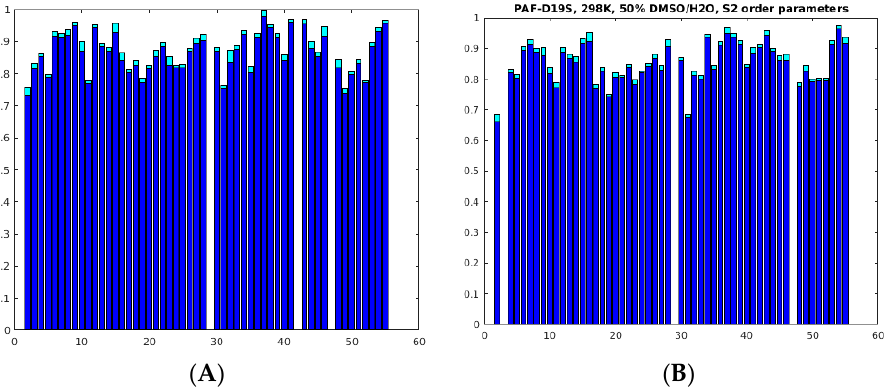
Figure 3. S 2 order parameters of the NH vectors in PAF (( A ), 310 K, 70.96 MHz) and PAF D19S , (( B ), 298 K, 50.68 MHz), as measured from 15 N relaxation experiments, and the Lipari–Szabo method was used for evaluation. Errors are shown on the top of the bars. A few data are not shown due to spectral overlap and from 29 ‐ Pro residue (see also Supplementary Table S1B).